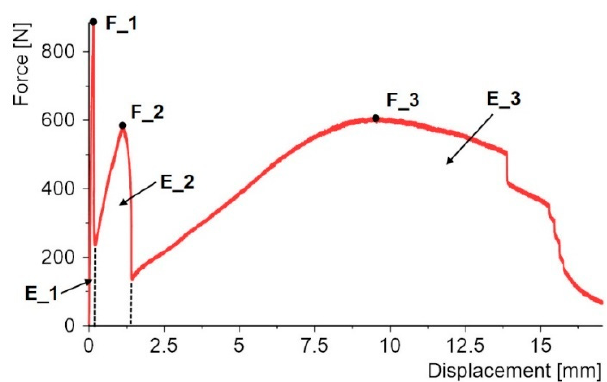
Figure 14. Determination of maximum forces and energies for triple-adhesive specimens.